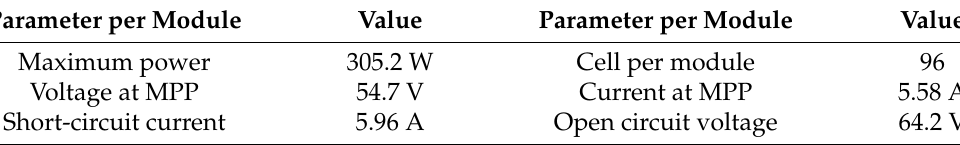
Table 2. SunPower SPR-305E-WHT-D model data.